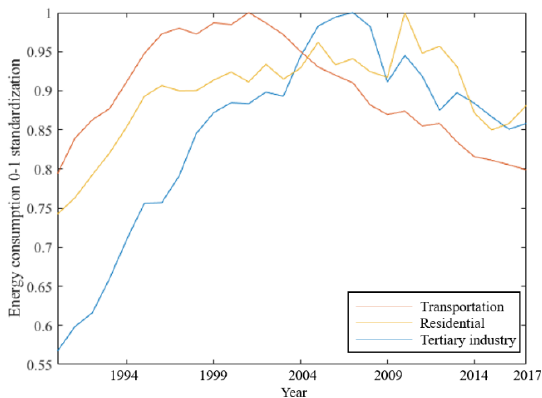
Figure 5. The 0–1 standardization of energy consumption in tertiary industry, transportation and residential.